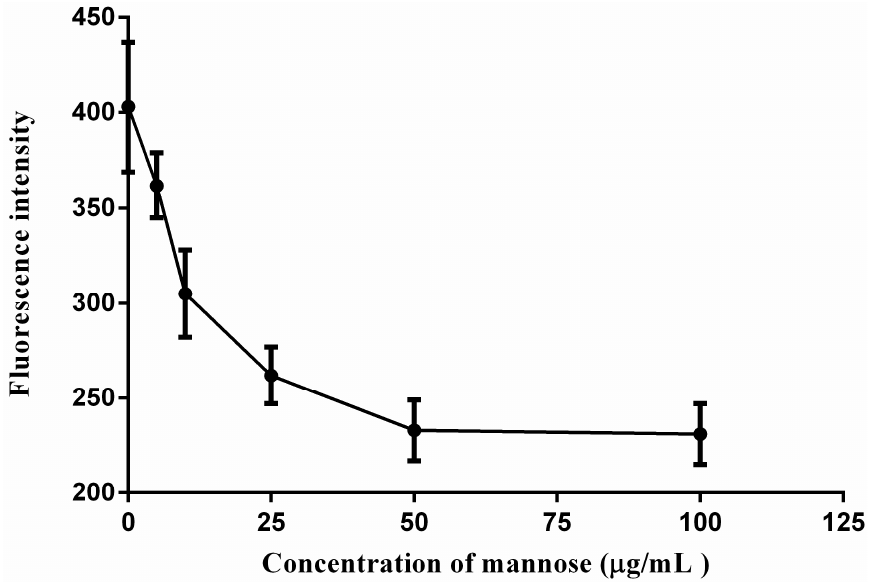
Figure 6. In vitro cellular uptake inhibitions by mannose.